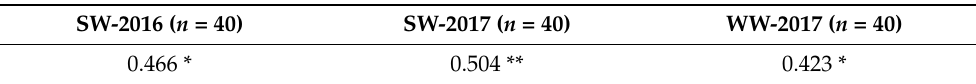
Table 10. Relationship between available P content in soil and wheat grain yield–simple correla- tion